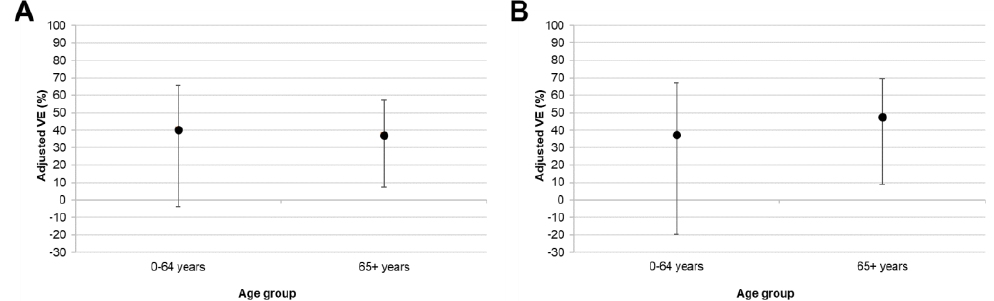
Figure3. AdjustedestimatesofVE(95%CI)againstalltypeAinfluenza( A )andsubtypeA(H1N1)pdm09 Figure 3. Adjusted estimates of VE (95% CI) against all type A influenza ( A ) and subtype ( B ) stratified by age A(H1N1)pdm09 ( B ) stratified by age group.